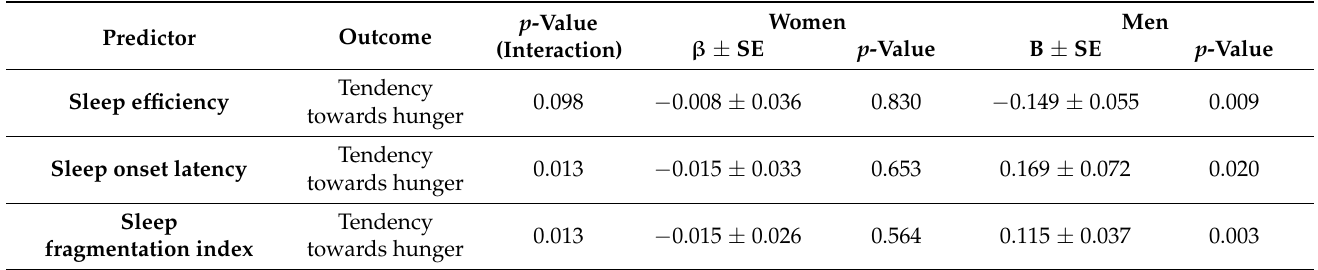
Table 3. Results of stratified analyses of sleep with eating behavior traits following significant interactions with sex.